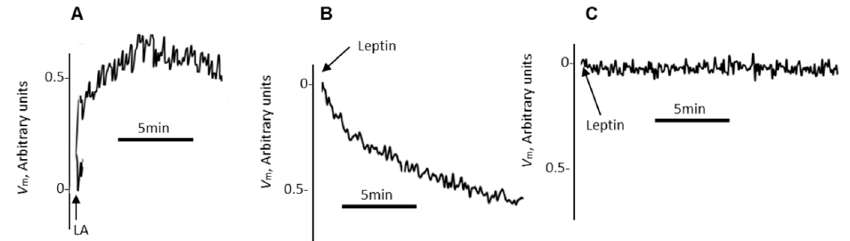
Figure 6. The effects of a LCFA and leptin on membrane potential ( V m ) in mouse TBC. The TBC (2 × l0 6 cells/assay) were loaded with the fluorescent probe, bis-oxonol, as described in Materials and Methods. The arrow heads indicate the time when the test molecules, LCFA, i.e., LA (20 μ M) in ( A ) and leptin (10 μ g/mL) in ( B , C ), were added into the cuvette. The right panel ( C ) shows the action of leptin in TBC, preincubated with wortmannin (100 nM) for 10 min. The Figure shows the single traces of identically reproduced experiments ( n = 5).